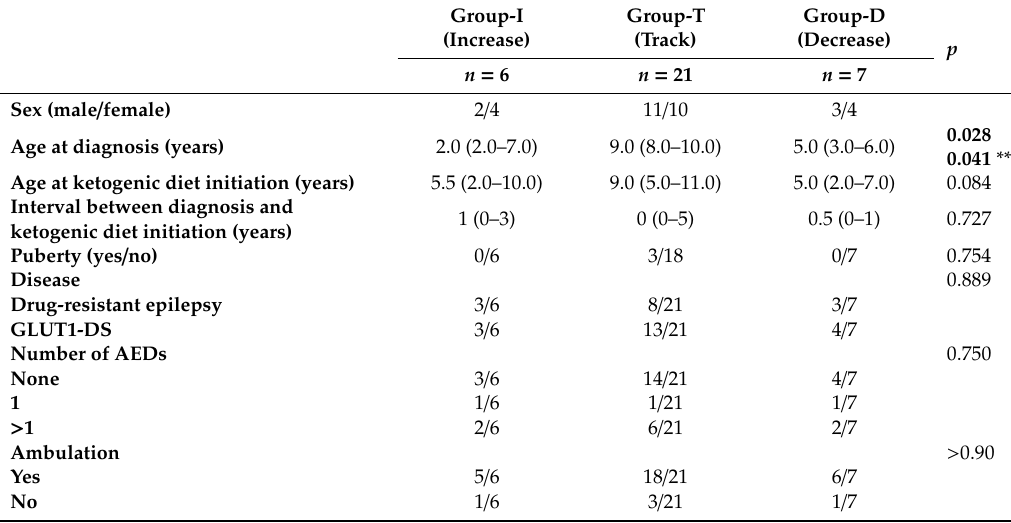
Table 3. Comparison of baseline characteristics in the three growth groups.